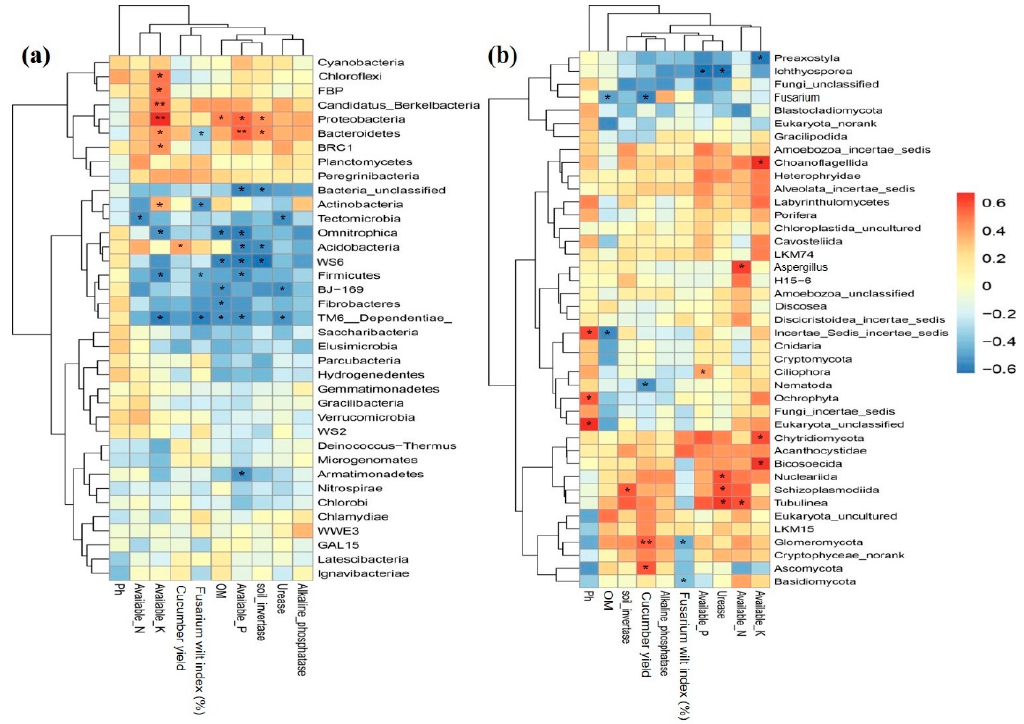
Figure 6. The heat map depicts the relationship of key soil edaphic factors, cucumber yield and Fusarium wilt incidence rate % with top bacterial ( a ) and fungal taxa ( b ). Soil samples were clustered using an unweighted pair group method with arithmetic mean (UPGMA) dendrogram based on Bray–Curtis similarities. The color legend and scale are provided in the figure ( blue means low relative abundance with negative association while yellow and red mean higher abundance with positive correlation). Shaded values indicate statistically significant (* p < 0.05; ** p < 0.01) associations with correlation.